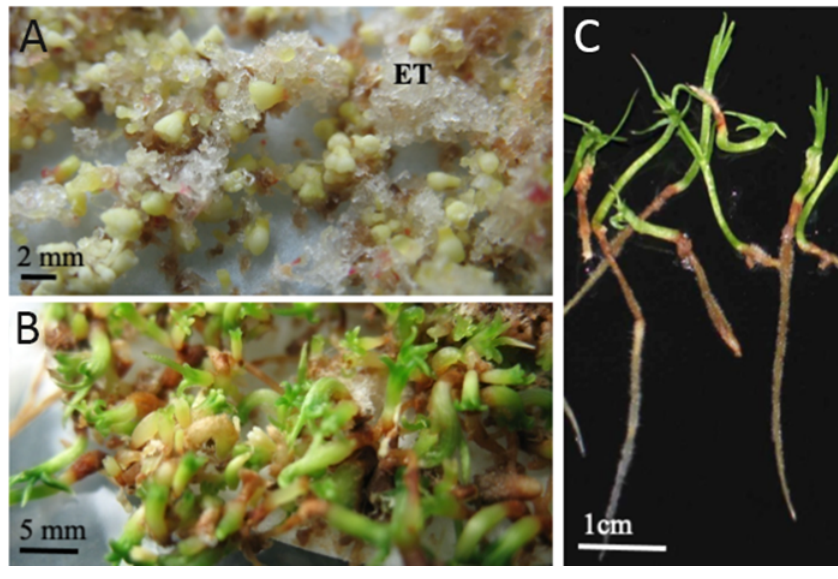
Figure 2 Somatic embryos of Picea omorika regenerated in vitro aer cryopreservation: ( A ) at the cotyledonary stage; ( B ) at the germination stage; ( C ) converted into somatic seedlings. ET – embryogenic